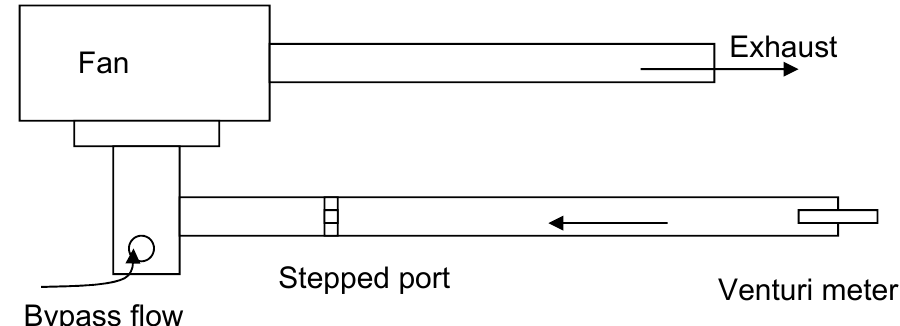
Figure 4. Airflow rig schematic: axisymmetric testing.